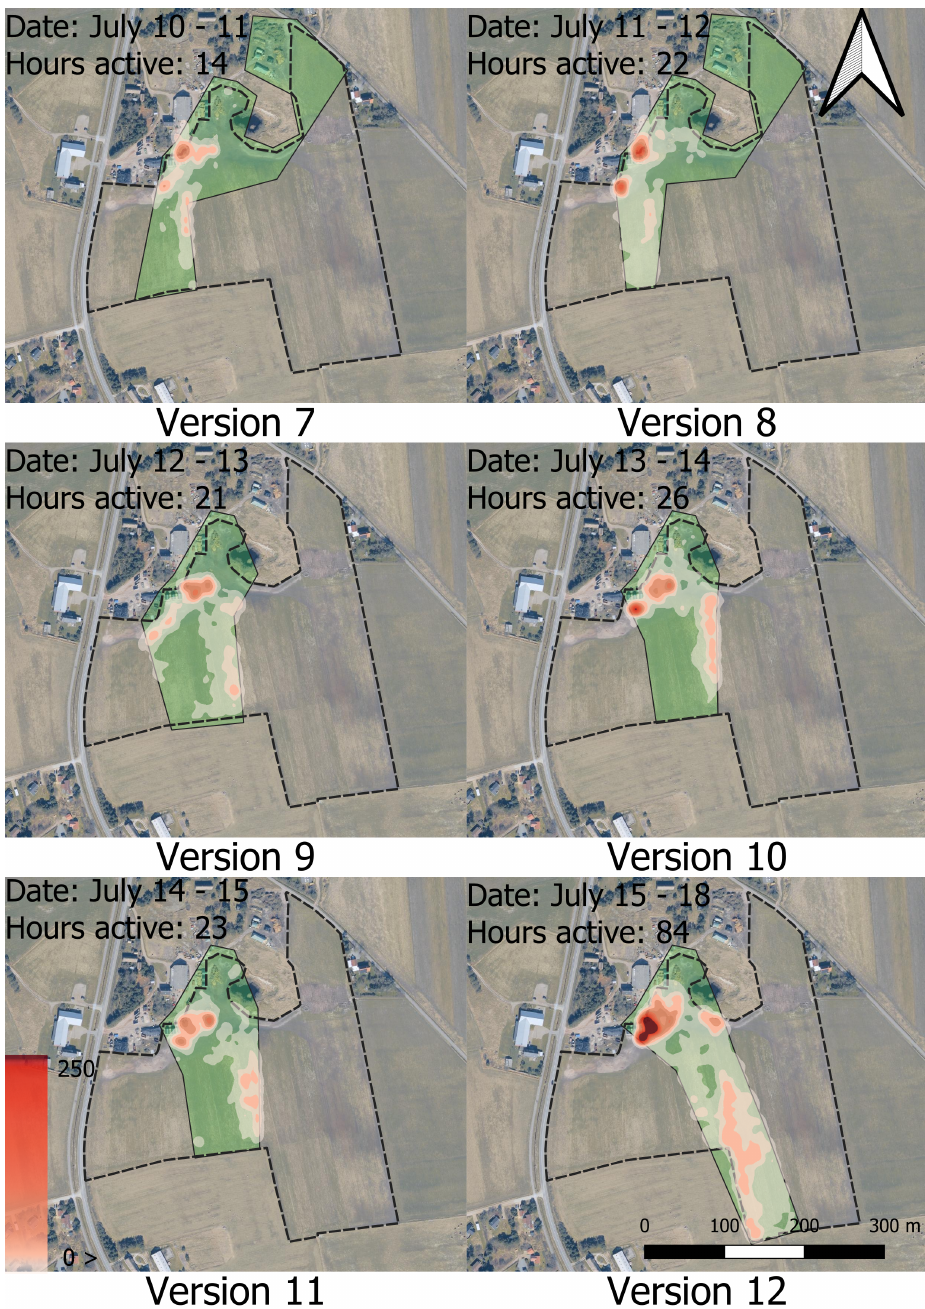
Figure A11. Heatmap series 2 visualising all Poll messages sent during the period from 10 July to 18 July. The green area shows the virtual enclosure area to which the bull calves were limited. The white to red colour indicates the number of Poll messages within a 10 m radius. The brightest colour represents the areas with the lowest density of Poll messages, while the darkest colour represents the areas with 250 or more Poll messages within the radius. The coordinates of the upper left corner of the map frame are 55°25 (cid:48) 23.131 (cid:48)(cid:48) E 8°23 (cid:48) 53.531 (cid:48)(cid:48) N. Contains data from the Agency for Data Supply and Infrastructure, Forårsbilleder Ortofoto-GeoDanmark, December